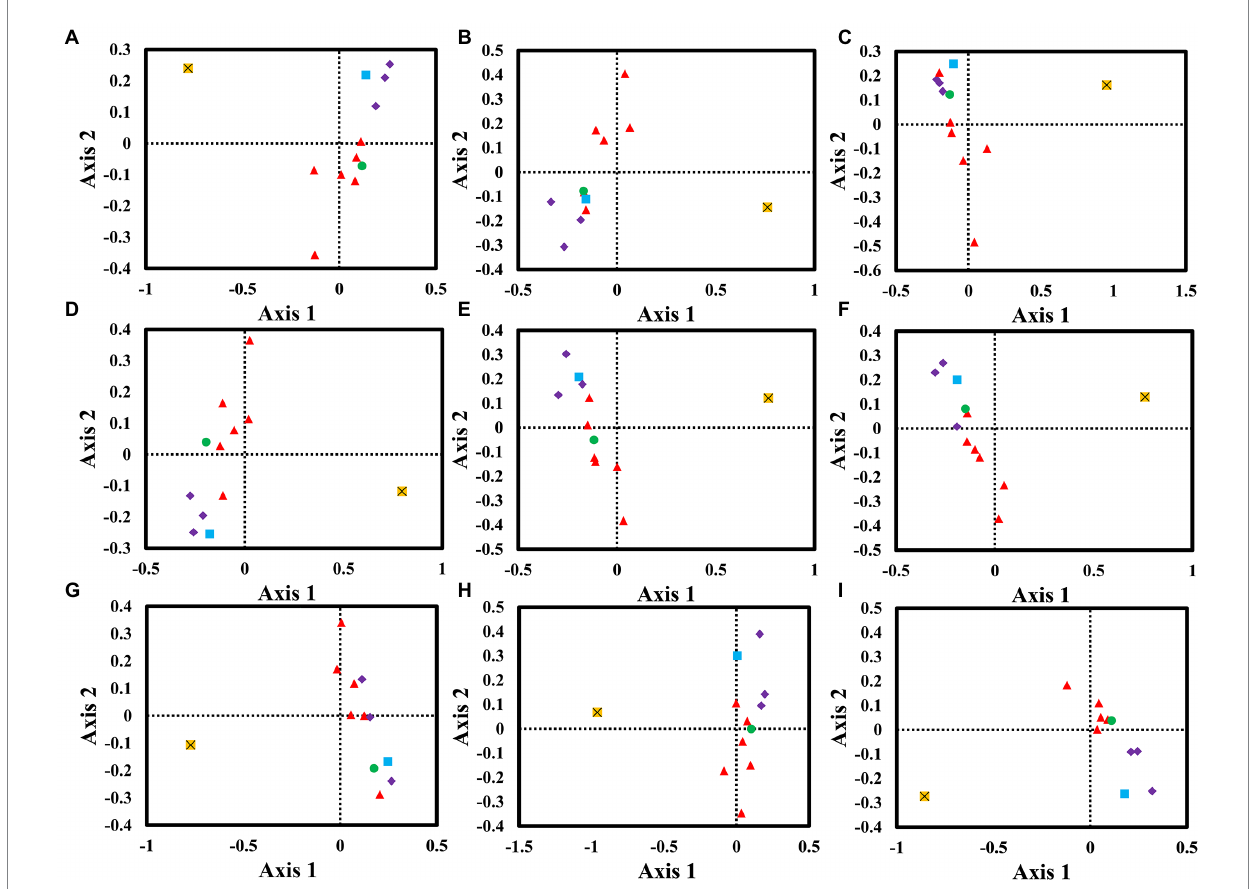
FIGURE 6 Correspondence analysis (COA) based on the relative synonymous codon usage (RSCU) values of 12 mitochondrial genes from nine Amanita species. Purple represents the cox gene, red represents the nad gene, green represents the atp6 gene, blue represents the cob gene, and yellow represents